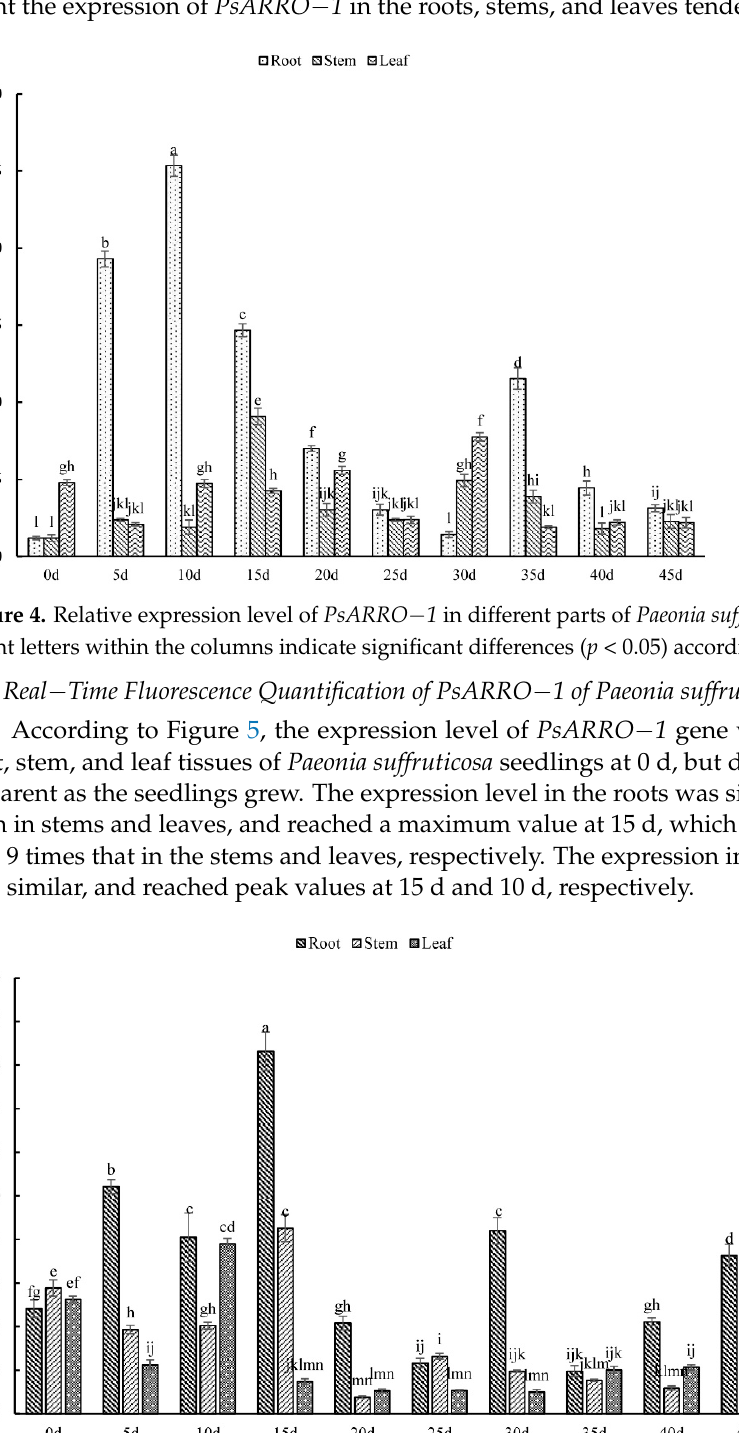
Figure 3. Relative expression of PsARRO − 1 at different stages of rooting. Different letters within the columns indicate significant differences ( p < 0.05) according to the Tukey test.